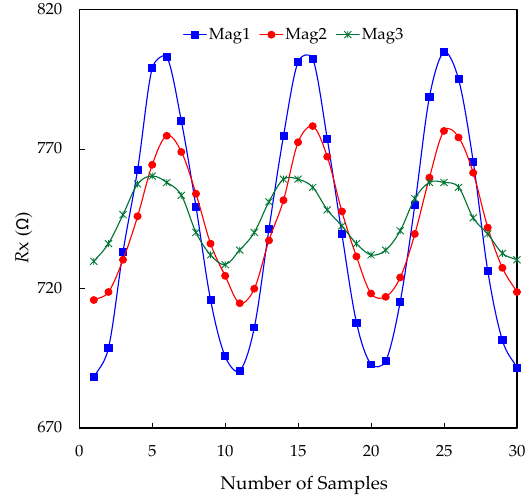
Figure 8. Results from Experiment B: R x varying sinusoidally at 1 kHz, measured at 10.2 kSa/s for three different levels of the magnetic field, where Mag1 > Mag2 > Mag3.